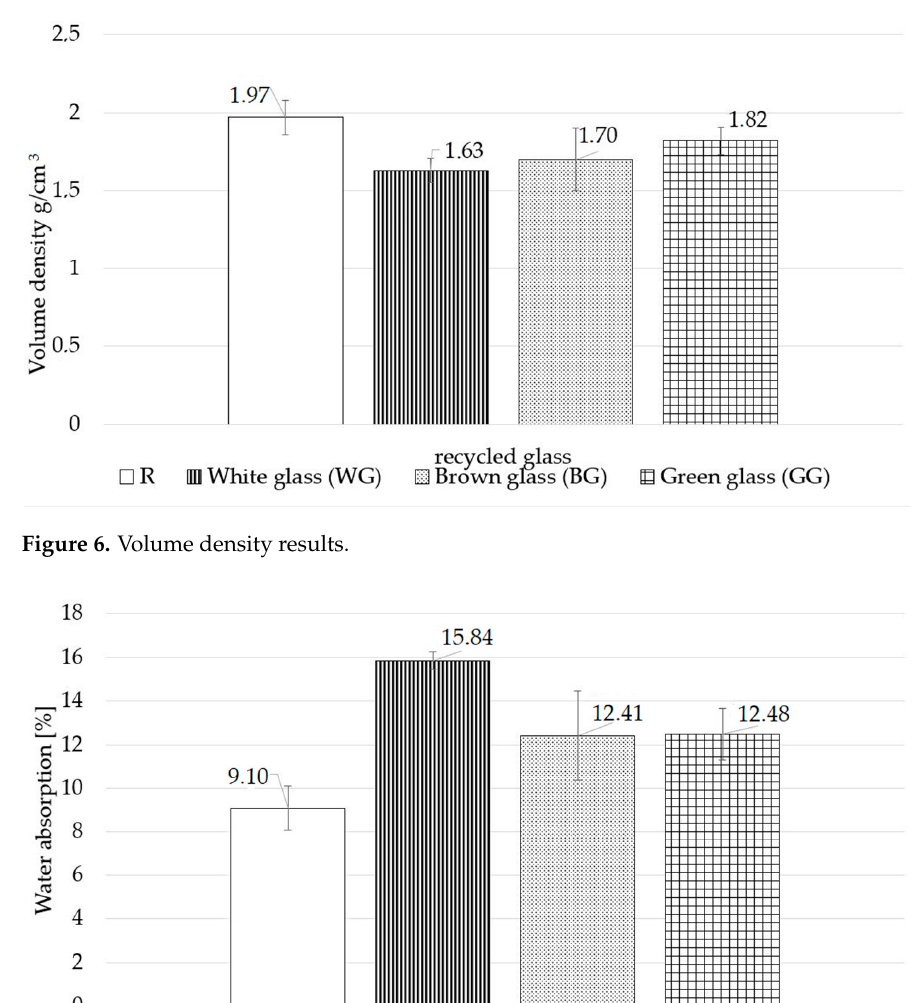
Figure 8. X-ray-pattern of WG, BG, and GG samples (symbols: A—aragonite, C—calcite, P—port- landite, S—spurrite, T—tobermorite, Q—quartz). The phase composition of the silica–lime products shown in Figure 8 indicates that calcium hydroxide (portlandite) formed in all samples with glass aggregate. Peaks typical of calcite are also found, confirming portlandite carbonation. Carbonation may cause the lack of cohesion of the sample subjected to compression, Figure 4. In the analysed samples, hydrated calcium silicates appear as hydration products. A peak characteristic of tober- morite (5–10 °2 θ ) reaches the highest intensity in GG sample. In the other samples, this peak does not occur. In all samples containing glass, however, a raised background is visible, which may be caused by the presence of unreacted glass and the low degree of structural order of formed hydrated calcium silicates. Their structure may be similar to the C-S-H phase structure formed in natural conditions [45]. This confirms the observation that in the autoclaving process, the presence of reactive silica in the amorphous state in- creases the amount of the C-S-H phase, but at the same time, the transformation of this phase into a more stable form is hindered [46]. When samples with different glass colours were tested, the main differences in the diffractograms were the intensities of the portlandite peaks. Significantly, for samples for